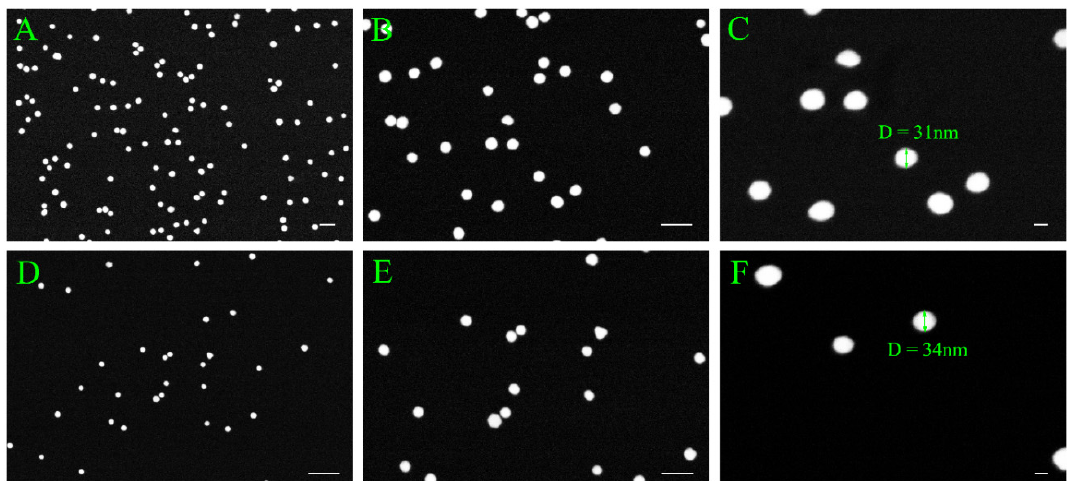
Figure 6. Comparison of presence and density of AuNP on the surface of chips A1 and B1 under high magnification: ( A ) AuNP distribution on chip A1 under 50,000 times magnification, scale bar stands for 100 nm; ( B ) AuNP distribution on chip A1 under 100,000 times magnification, scale bar stands for 100 nm; ( C ) AuNP distribution on chip A1 under 200,000 times magnification, scale bar stands for 20 nm; ( D ) AuNP distribution on chip B1 under 50,000 times magnification, scale bar stands for 200 nm; ( E ) AuNP distribution on chip B1 under 100,000 times magnification, scale bar stands for 100 nm; ( F ) AuNP distribution on chip B1 under 200,000 times magnification, scale bar stands for 20 nm.